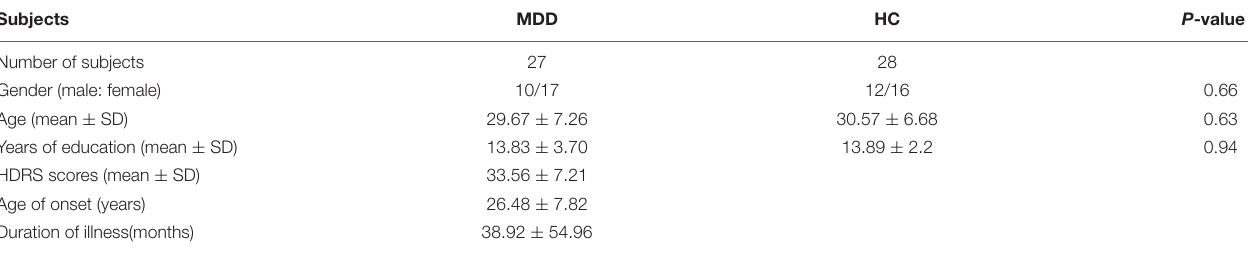
TABLE 1 | Demographics and clinical characteristics of the used subjects.